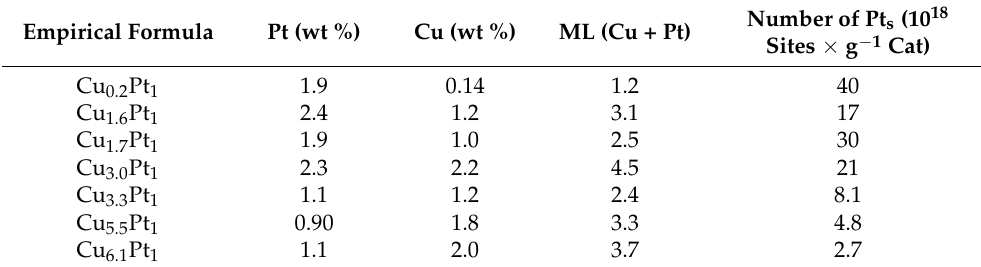
Figure 2. Deposition kinetics for a feed ratio of ( a ) 1:1 = Cu:Pt ( b ) 3:1 = Cu:Pt. The solid line indicates the total amount of metal added, the red line indicates metal deposited in the mixed shell, and the blue line indicates the metal salt remaining in the bath. Final shell composition was ( a ) Cu:Pt = 0.23:1 and ( b ) Cu:Pt = 1.6:1. Results from deposition kinetics shown for all materials made plotted ( c ) where the amount of Cu:Pt added by a syringe pump (target) is compared to the amount (Cu:Pt) actually deposited after 120 min. Linear regression is shown by the dashed line. Table 1. Summary of catalysts prepared and tested with cyclic voltammetry. One ML is defined as the number of atoms required to cover the surface of the Pd core. The surface concentration of the Pd core was determined by H-titration of O-pre-covered Pd. Weight loadings of Pt and Cu refer to weight loadings of each metal added to the 5% Pd/C. The Pd loading was not factored into the Pt and Cu loadings. The concentration of Pt surface sites was determined from the H 2 titration of O-pre-covered Pt